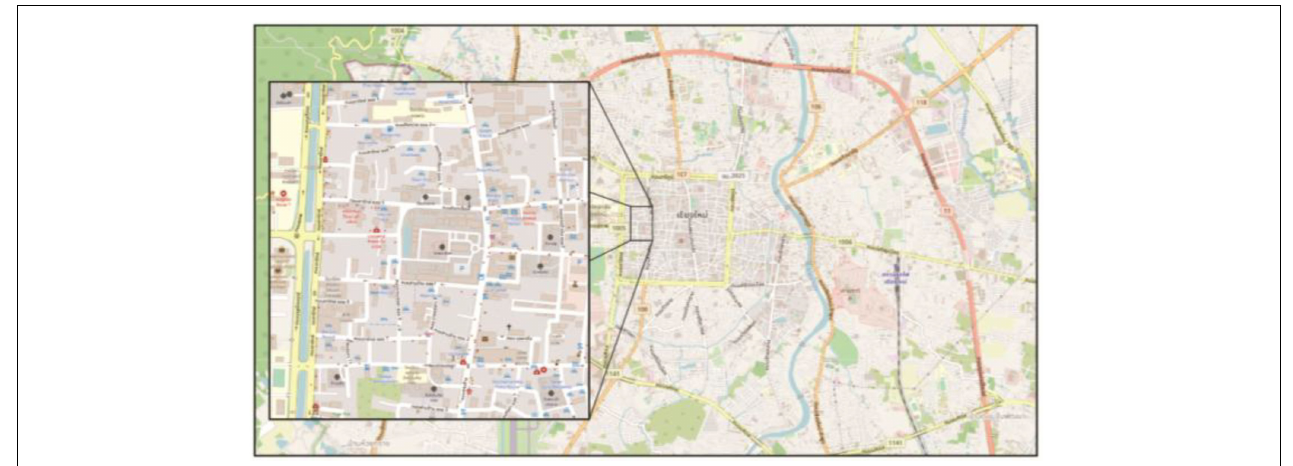
FIGURE 2 | Location of Muen Ngoen Kong Community in Chiang Mai, Thailand.